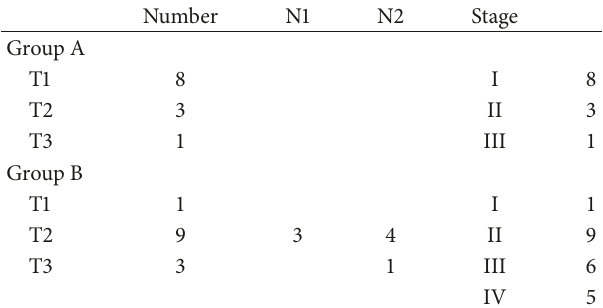
Table 2: TN and stage